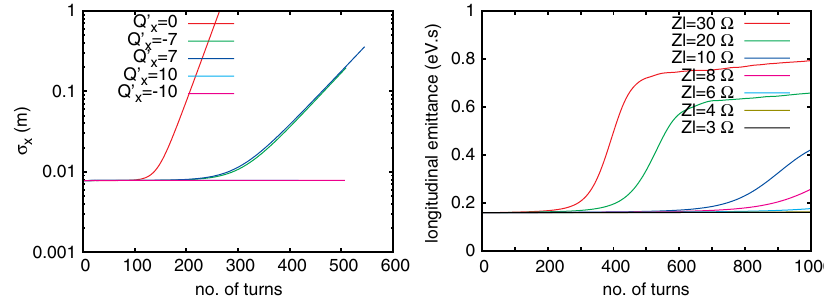
FIG. 1. Horizontal beam size evolution for various values of chromaticity assuming a transverse impedance of 1 M(cid:1) = m , Q R ¼ 1 , ¼ 1 GH z (left). Longitudinal emittance evolution for different values of shunt impedance (right). The lines for 3 and 4 (cid:1) lie on top f R of each other in the figure.